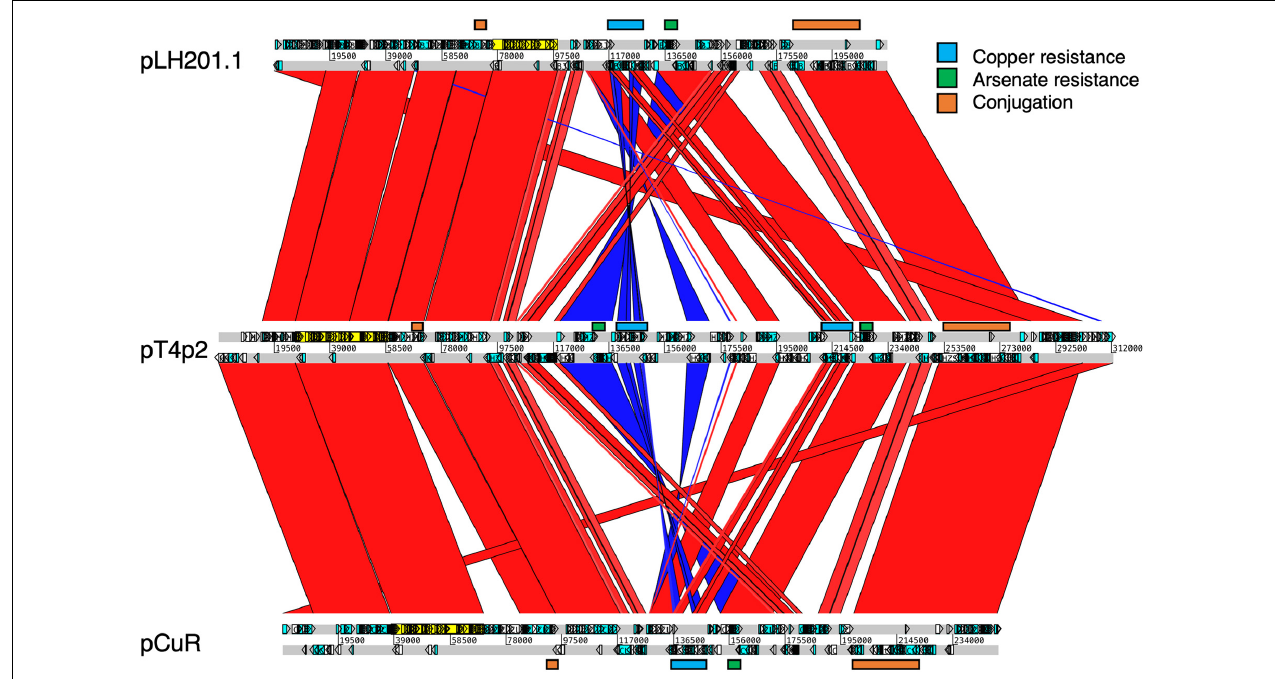
FIGURE 6 | Comparison of plasmids containing copper resistance genes in pT4p2, pCur and pLH201.1. Syntenic regions are presented in red color and inverted regions are in blue. Genes involved in copper/arsenate resistance and conjugation are highlighted along the plasmid